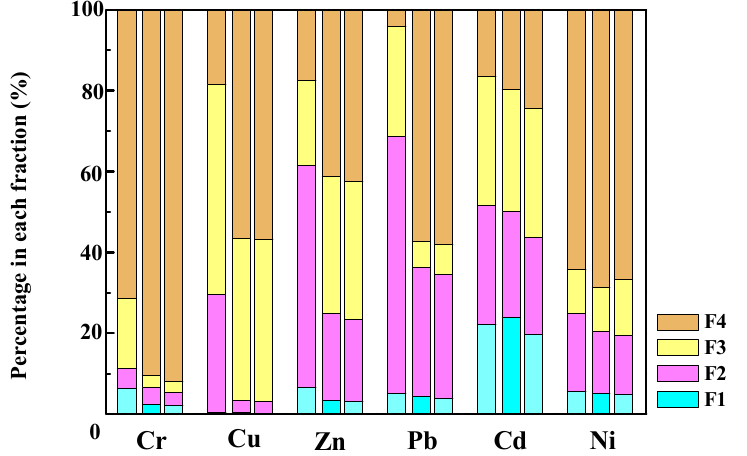
Figure 7. Heavy metal fraction of municipal sludge (left), SB (midial), and SB-NZVI (right).